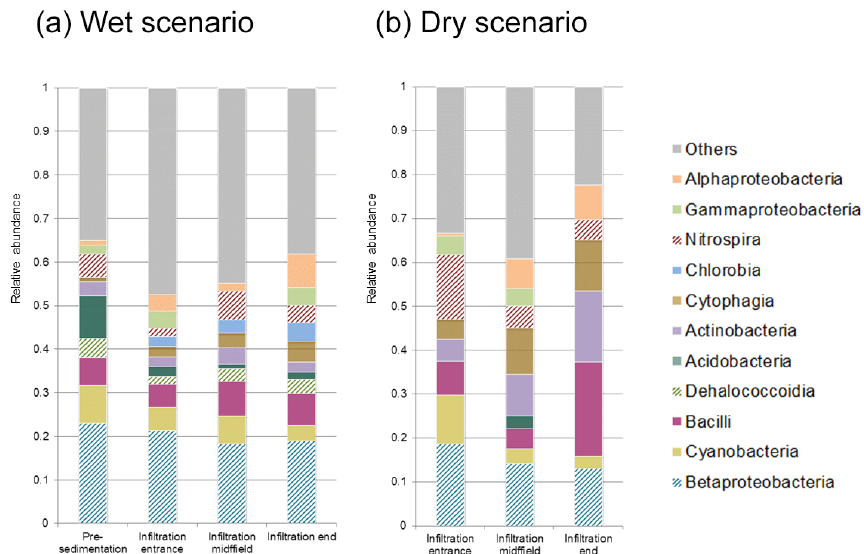
Figure 8. Bacterial community structure of soil samples from pre-sedimentation and infiltration basins. Class relative abundances calculated for wet (a) and dry (b)